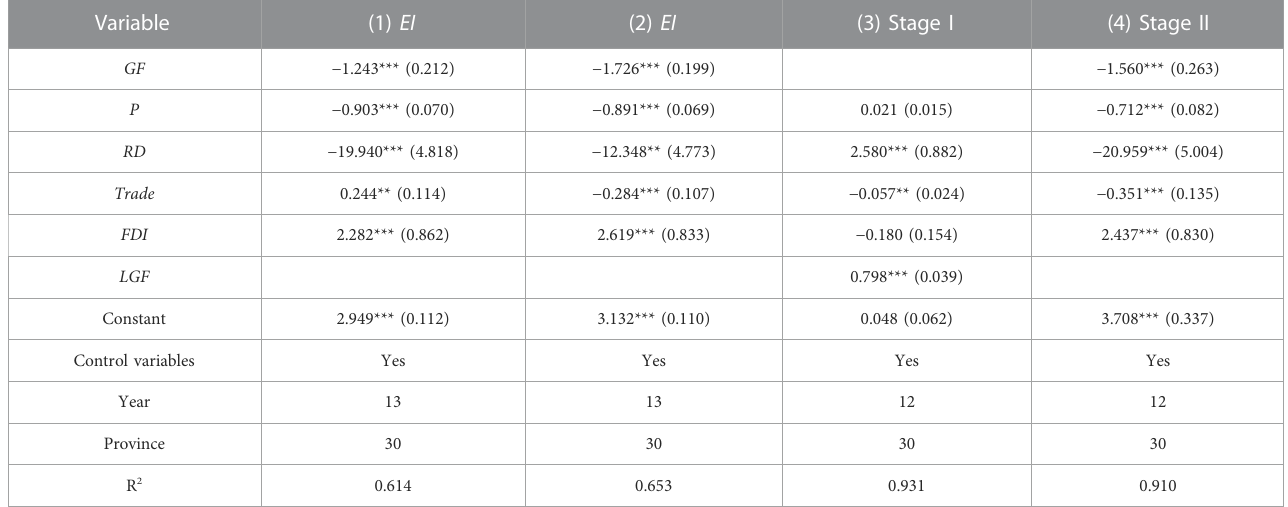
TABLE 7 Robustness tests for the impact of green fi nance on energy intensity.